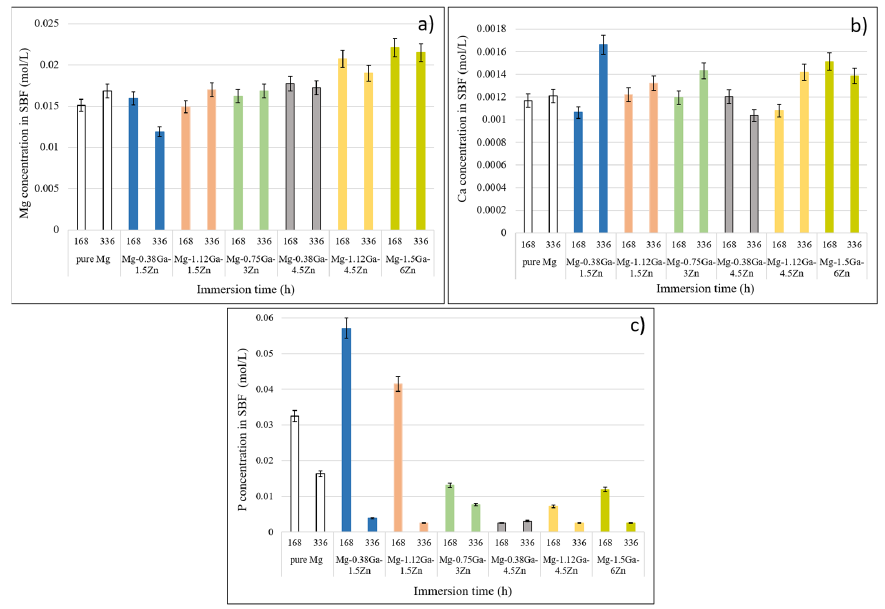
Figure 9. Ionic concentration of remaining SBFs, ( a ) Mg, ( b ) Ca and ( c ) P after 168 and 336 h of immersion of the alloys.